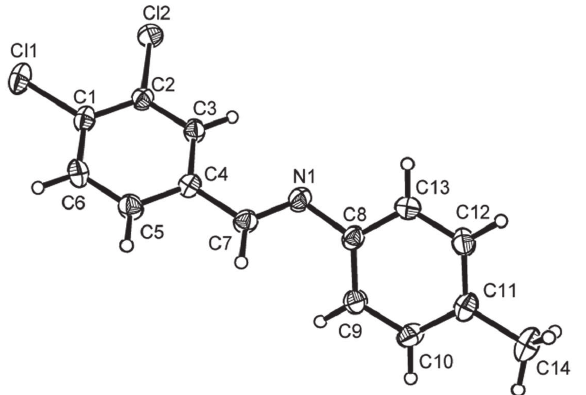
Table 1: Data collection and handling.